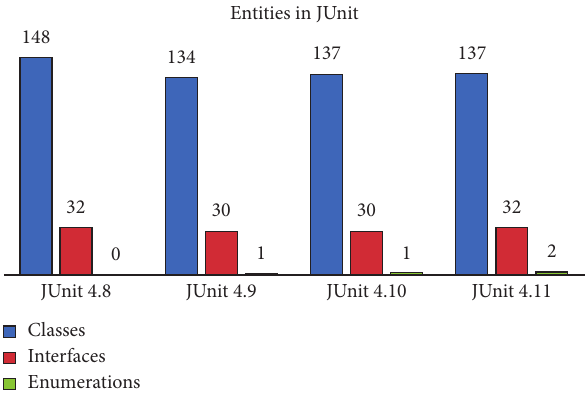
Figure 15: Count of entities in Junit.